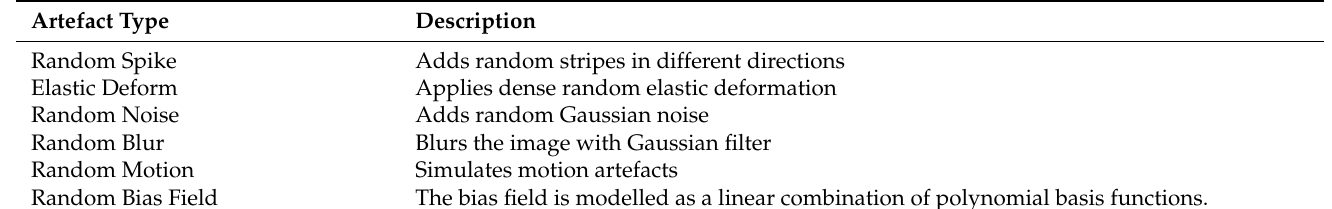
Table A1. Different types of MR artefacts, simulated using TorchIO Random Transformations.